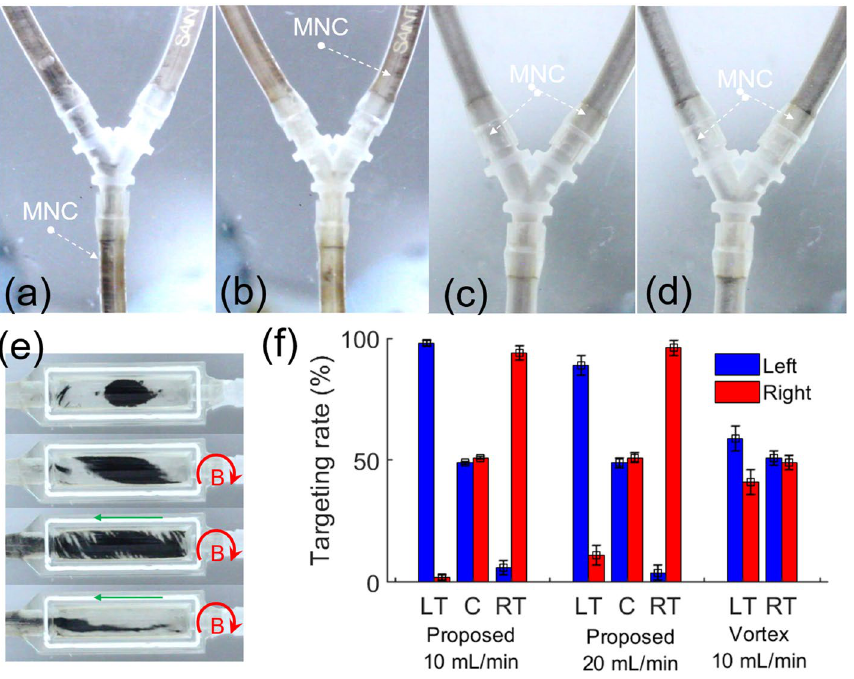
Figure 7. Targeting performance of MNR in a channel with flow condition. A frame capture of targeting test using the proposed method to ( a ) left channel, ( b ) right channel under a flow rate of 20 mL/min. A frame capture of targeting test using vortex-like swarm to ( c ) right and ( d ) left channel under a flow rate of 10 mL/min. ( e ) A time-lapse vortex formation test under a flow rate of 10 mL/min, where the green arrow represents the flow direction. ( d ) Recorded targeting rate of the MNR using the proposed method under a different flow rate of 10 mL/min and 20 mL/min and vortex-like swarm with a flow rate of 10 mL/min. Where LT, C, and RT are left targeting, control, and right targeting, respectively. (Please refer to the supplementary videos for more details of these